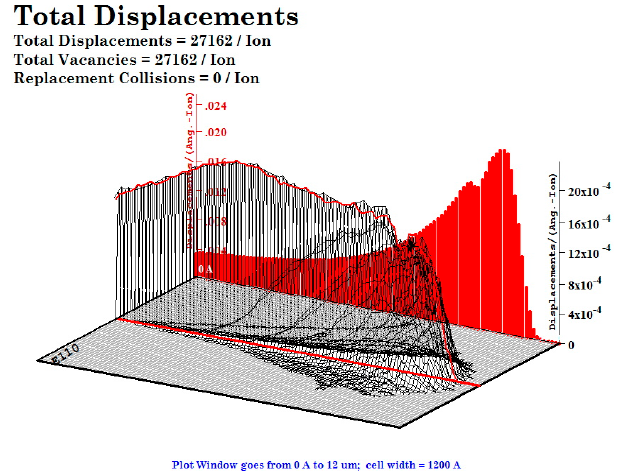
Figure 4. Damage caused by 120 MeV Tc in E110 alloy.